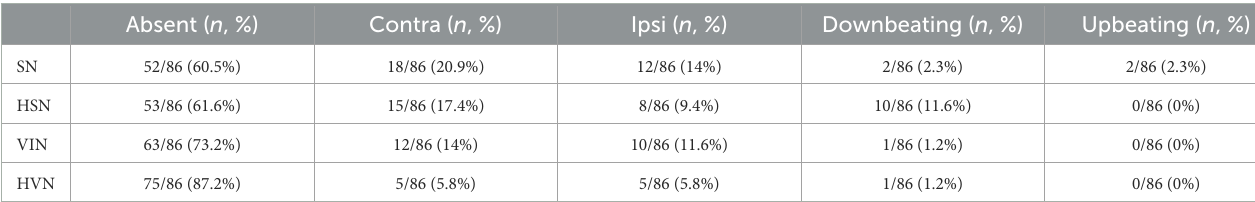
TABLE 1 Video-Frenzel findings of the overall cohort of 86